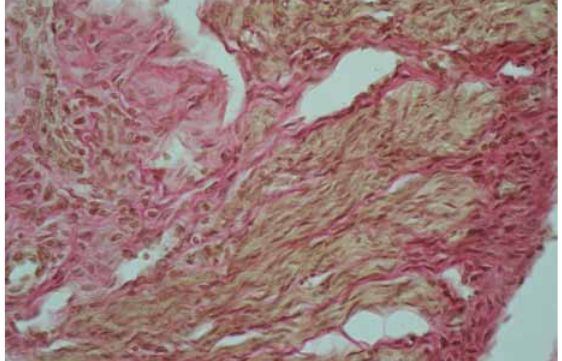
Figure 2. Photomicrography. Collagenization myometrium. Stained by Van Gisone. Increase 400.